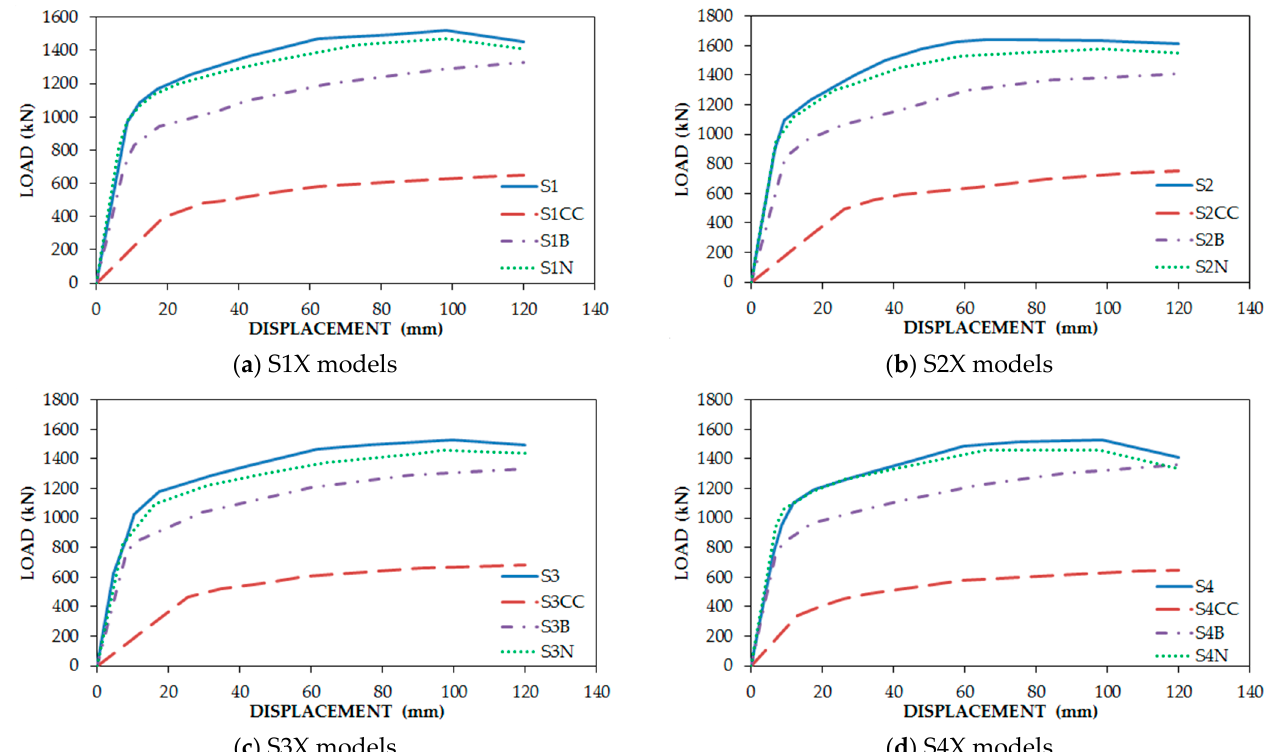
Figure 7. Comparison among backbone graphs of FE models based on the type of connections.